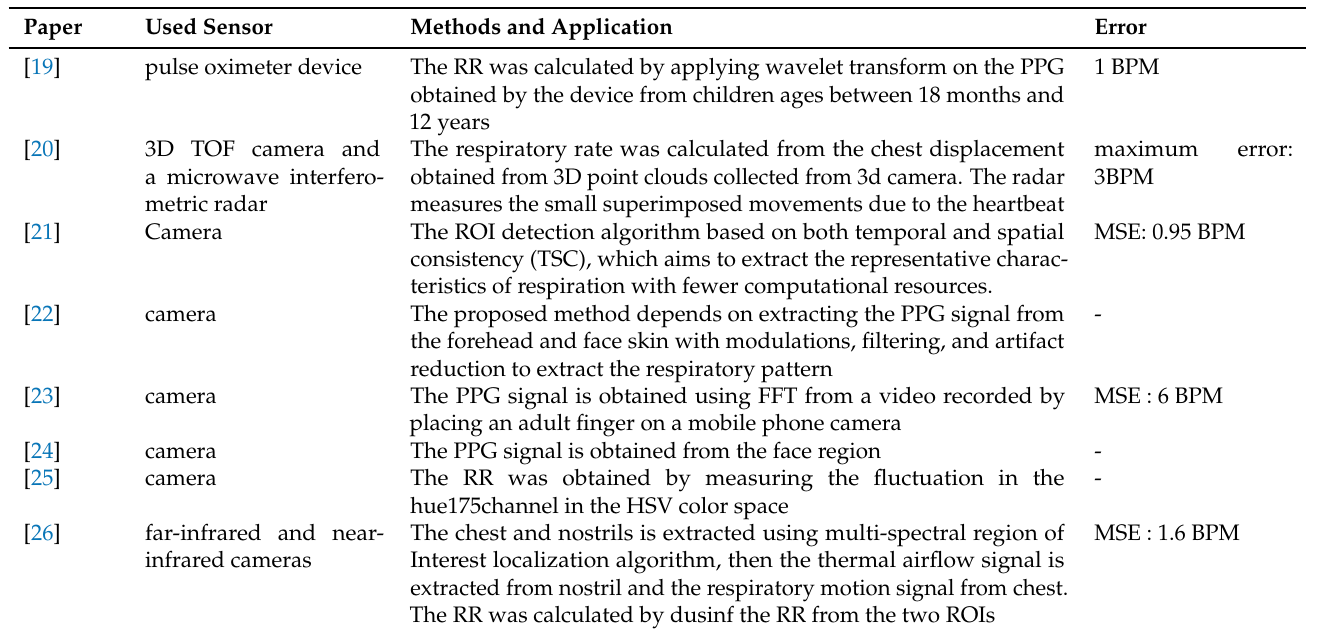
Table 1. Summary of the respiratory rate